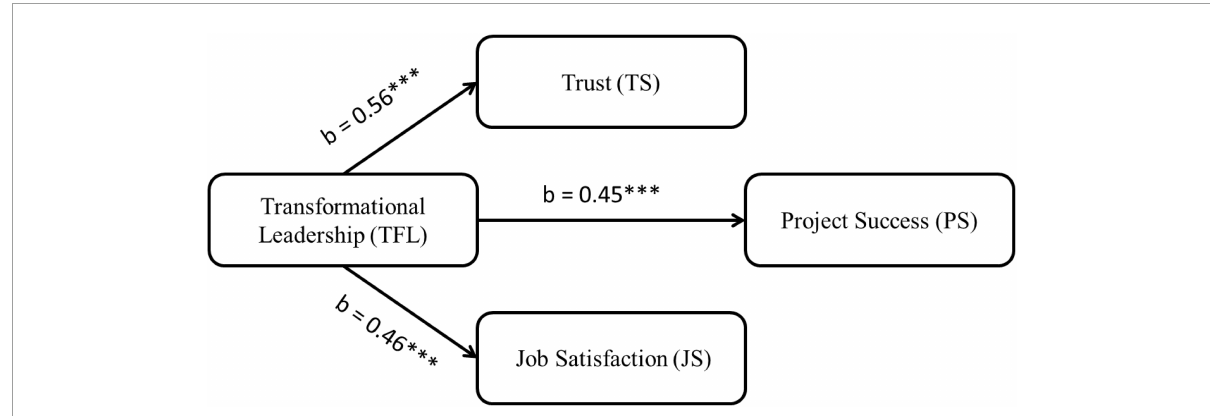
FIGURE2 Model 1. X 2 /df = 1.94, p < 0.001, RMSEA = 0.035, GFI = 0.963, CFI = 0.962, TFI = 0.965. ∗ p < 0.05, ∗∗ p < 0.01, ∗∗∗ p < 0.001.